Question: What visual encoding does this figure use to show its data?
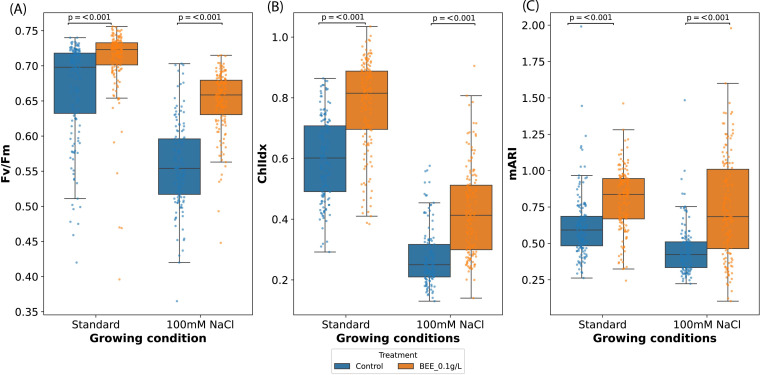
Answer: line